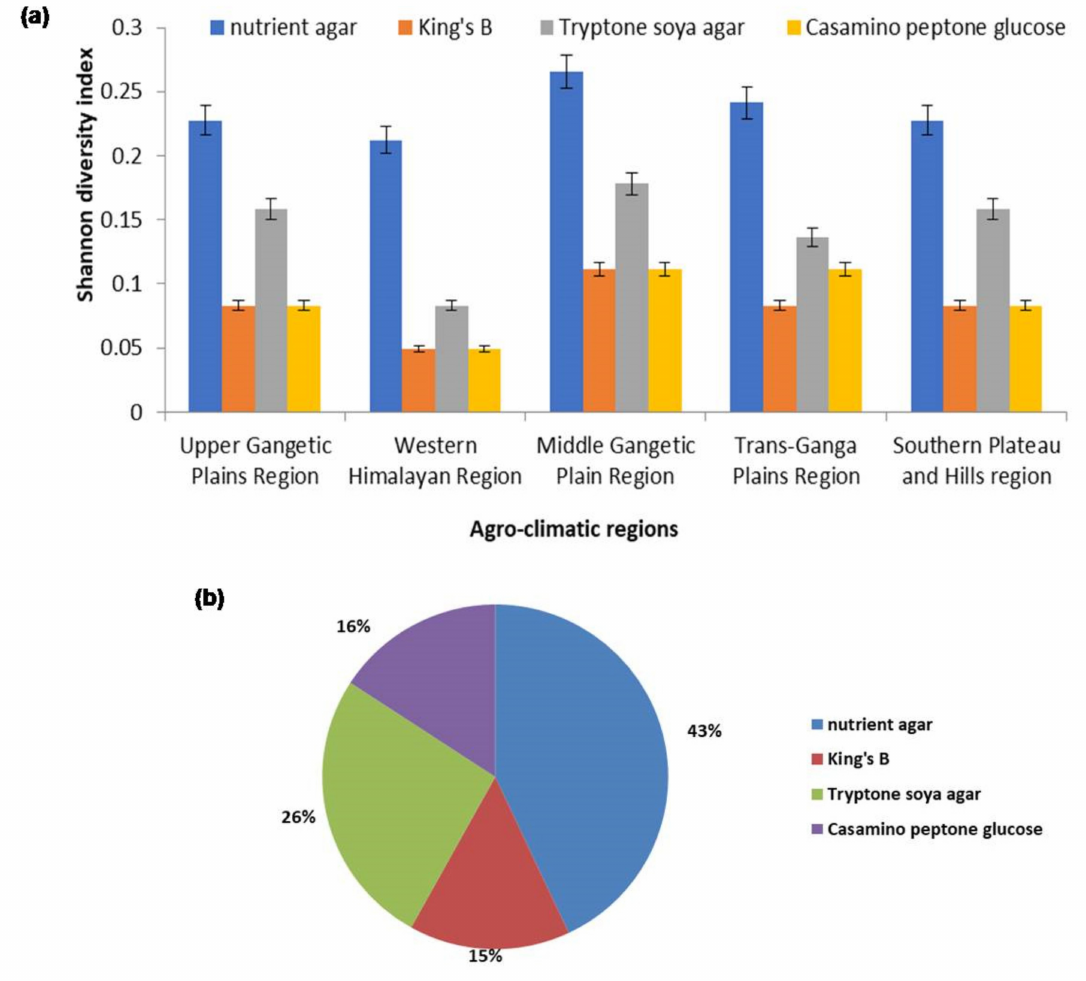
Figure 1. ( a ) Diversity index of rhizobacterial population isolated from rhizospheric soil samples from different agroclimatic zones on different microbiological media. The results are expressed as average of three replications and error bars indicate standard deviation of the means; ( b ) Shannon diversity index to access the abundance of rhizobacterial population on different